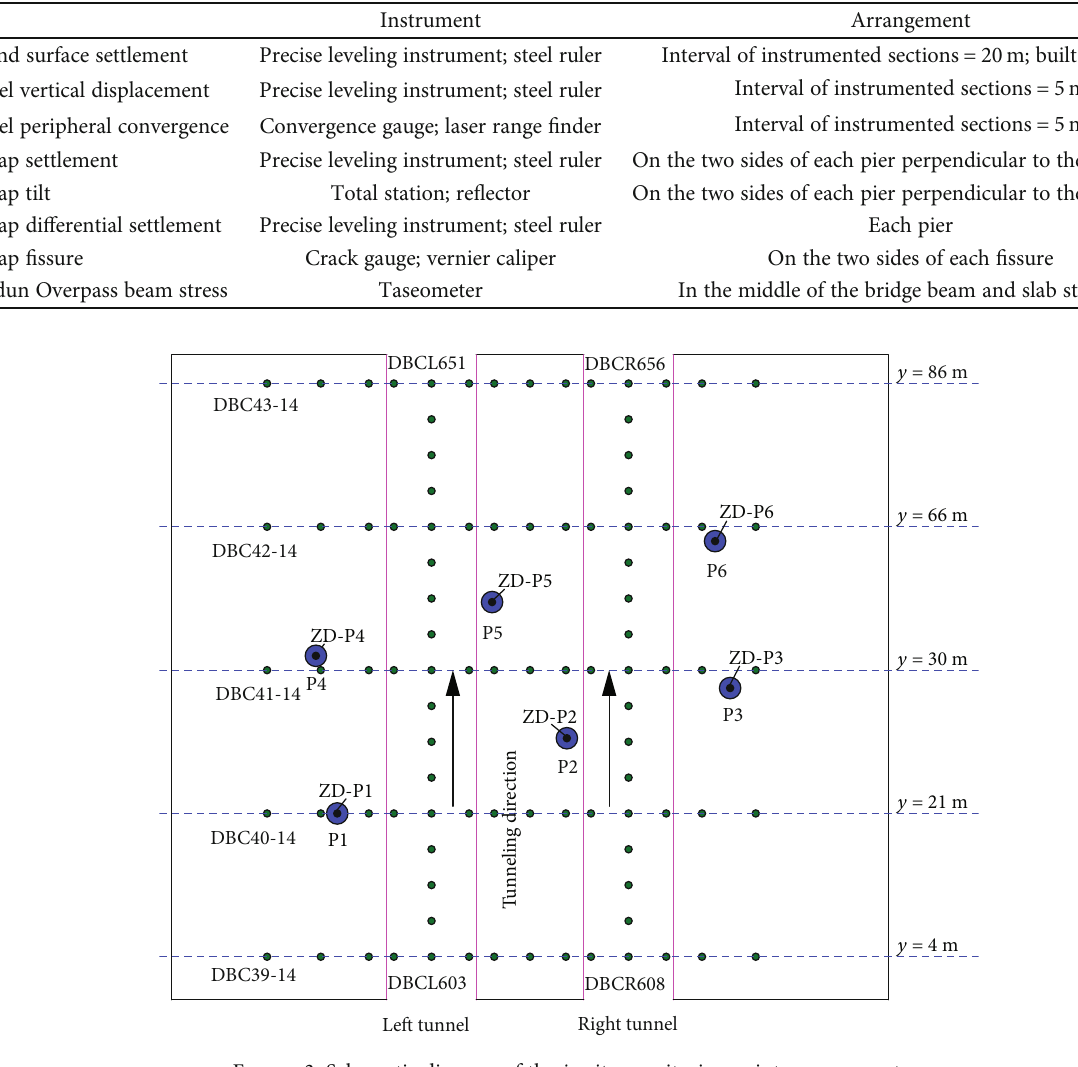
Figure 3: Schematic diagram of the in situ monitoring point